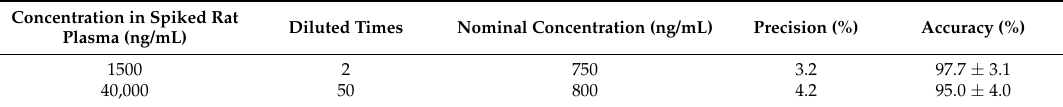
Table 4. Dilution integrity test for FTS analysis.